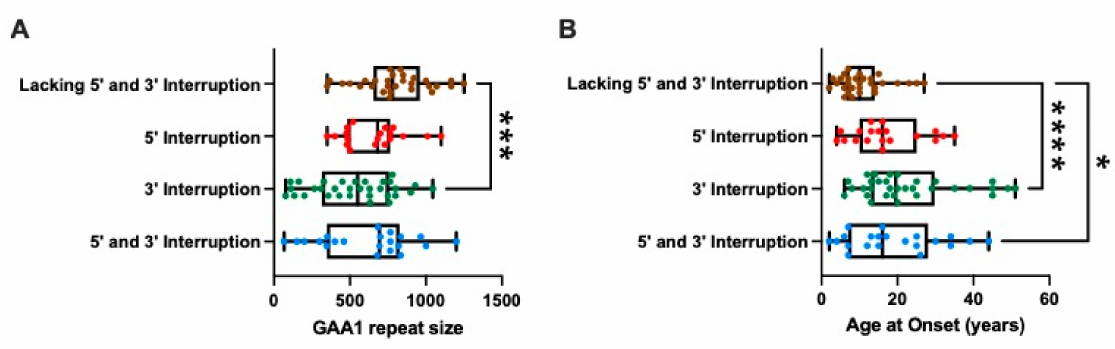
Figure 2. Interruption of the FXN GAA repeat tract is associated with shorter GAA1 repeat sizes and a later age at disease onset. ( A ) Box-and-whisker plot showing the distribution of the GAA1 repeat sizes for each interruption subgroup of the cohort. Kruskal–Wallis and subsequent Dunn’s multiple comparisons tests show that the 3 (cid:48) interruption subgroup has significantly smaller GAA1 repeat sizes compared to the subgroup lacking 5 (cid:48) and 3 (cid:48) interruptions. Other subgroup comparisons were not significant. ( B ) Box-and-whisker plot showing the distribution of ages at disease onset across each interruption subgroup of the cohort. Kruskal–Wallis and subsequent Dunn’s multiple comparisons tests show that both the 3 (cid:48) interruption subgroup and the 5 (cid:48) and 3 (cid:48) interruption subgroup have significantly later ages at disease onset compared to the subgroup lacking 5 (cid:48) and 3 (cid:48) interruptions. Other subgroup comparisons were not significant. The whiskers indicate the minimum and maximum values whilst the box shows the 25th to 75th percentiles of the data with a line indicating the median. * p ≤ 0.05; *** p ≤ 0.001; **** p ≤